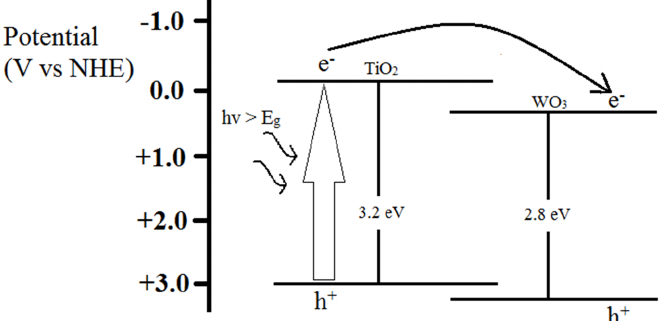
Figure 7. Suppression of recombination of photogenerated carriers due to coupling of WO 3 and TiO 2 .